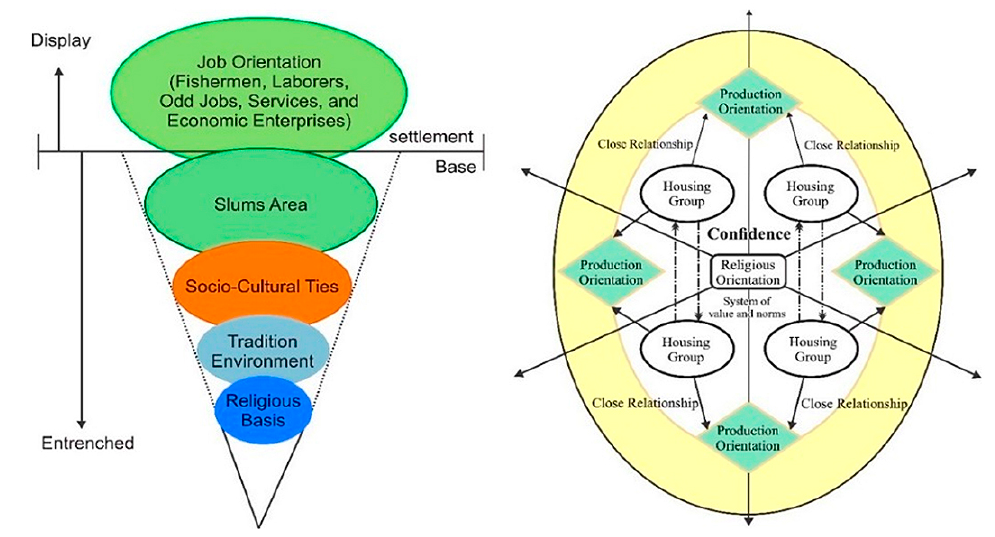
Figure 2. The display pattern of the socio-cultural life of the community in slum settlements in Makassar City. (A) Before the change; (B) After the